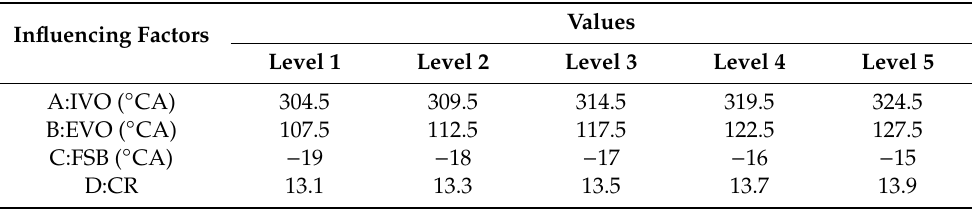
Table 7. Configuration of the influencing factors.